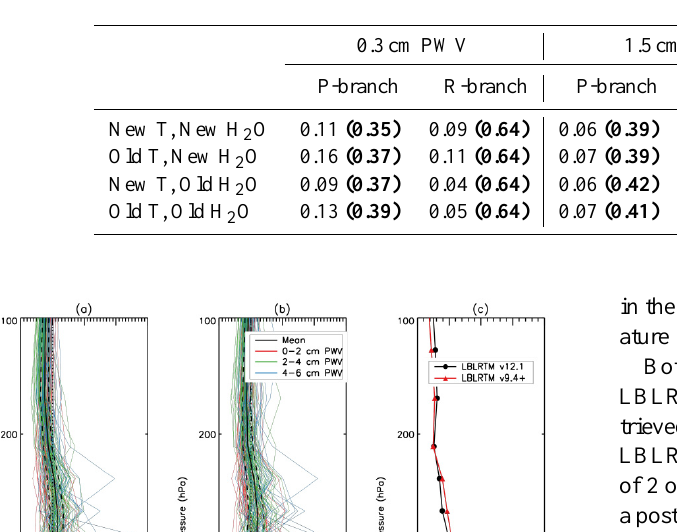
Table 4. Water vapor retrieval brightness temperature residuals (mean and RMS in K, RMS in bold) for different combinations of retrieved temperature profiles and H 2 O spectroscopy.